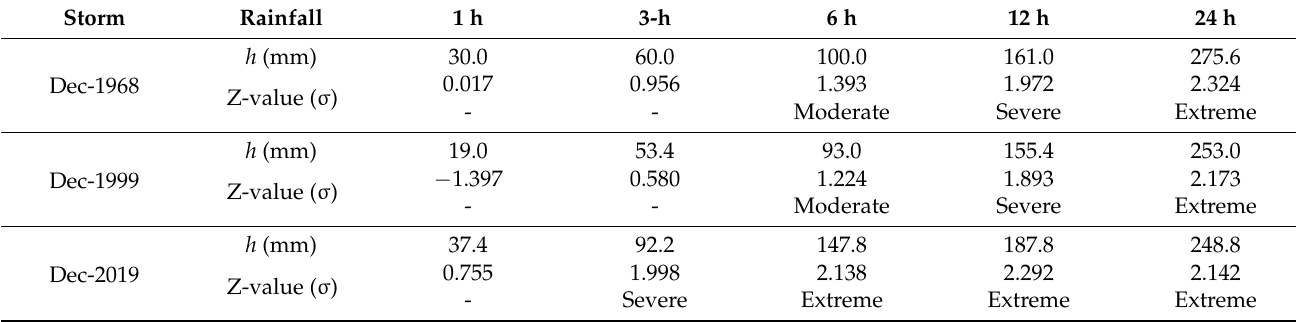
Figure 14. Z-value time series of the annual maximum rainfall (blue circles are the observed data; gray circles are one of the 10,000 synthetic filling data series used: ( a ) 1 h, ( b ) 3 h, ( c ) 6 h, ( d ) 12 h and ( e ) 24 h. Blue dashed lines are the trend lines of the observed time series, while gray dashed lines include the synthetic data. Table 5. Actual maximum rainfall intensities, h (mm), of the three storm events which caused the landslides of S. Martino V.C.; the Z-values (standard deviations, σ ) of the events were computed from three-parameter lognormal distribution for the 1-h rainfall and from three-parameter loglogistic distribution for the 3-, 6-, 12- and 24-h rainfall series.